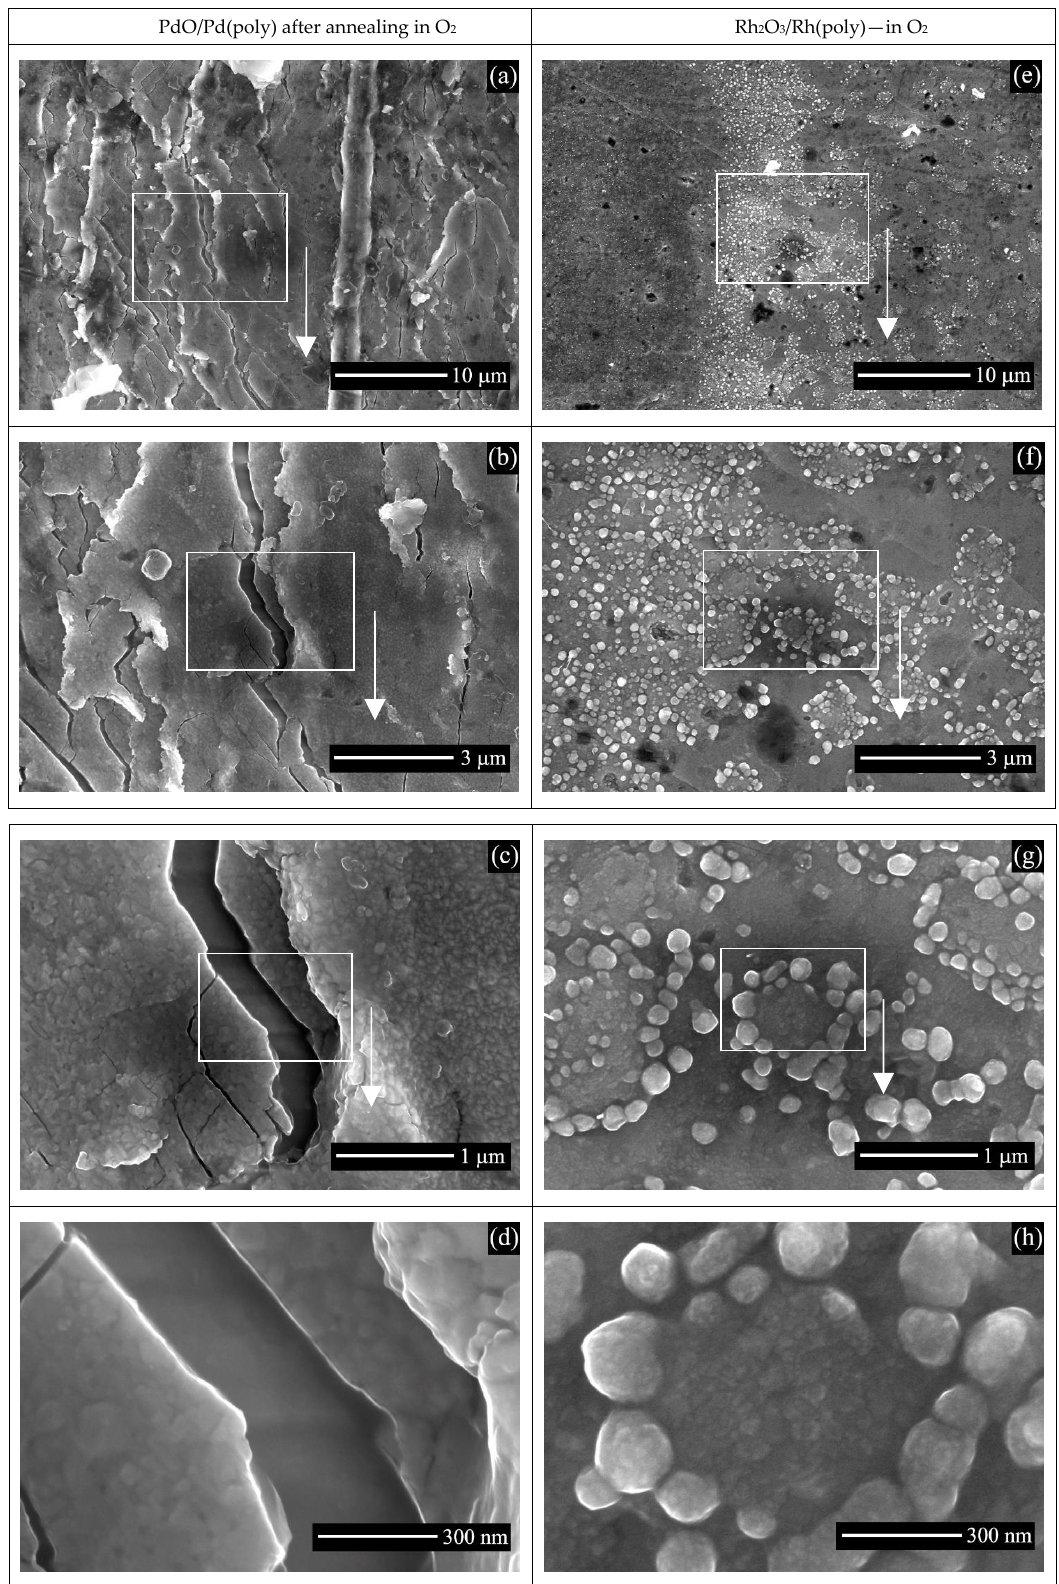
Figure 3. SEM image of the surface of samples Pd(poly) ( a – d ) and Rh(poly) ( e – h ) after annealing in О 2 at Р o 2 = 1 bar and 1100 K for 3 h. Images were obtained in SE mode at E 0 = 20 keV; rectangles indicate the regions represented by images with a higher magnification. For Rh(poly), a continuous dark layer is detected at low magnifications; a vertical strip ca. 10 µm in width consisting of bright particles is seen at the center of this layer (Figure 3e). Images in Figure 3f,g show spherical particles with a size of 100 – 200 nm. One particles. Taking into account that the oxygen concentration in Rh(poly) after annealing in О 2 at 1100 K is equal to 61.1 at.% (Figure 2а), the surface l ayer in Figure 3e – h can be attributed to Rh 2 O 3 oxide. For Rh, Pt and Pd, the 1100 K value is close to the Tamman temperature ( Т / Т melt ~0.5) for these metals because the Т / Т melt value for them is 0.49, 0.54 and 0.6, thus indicating high mobility of atoms of these metals. As a result, recrystalliza- tion and oxidation processes, forming the oxide particles and crystal facets on the grain surface, proceed very intensely. According to Figure 2а, at 1100 K in the О 2 atmosphere, the oxygen concentration on Pt(poly) is ca. 10.0 at.%, on Pd(poly) — 48.6 at.%, and on Rh(poly) — 61.1 at.%. On Pt(poly), O atoms are accumulated on such defects as grain boundaries and dislocations; the dissolution of oxygen in the metal lattice is not observed [21]. On Pd(poly) and Rh(poly), О atoms both penetrate the defects and intercalate in the lattice of metals. These processes lead to the formation of particles and/or crystals of PdO and Rh 2 O 3 oxides on the Pd and Rh surfaces. This is demonstrated by SEM images of the surface of samples after annealing in О 2 at 1100 K. For Pt(poly), the observed surface is typical of the recrystallized polycrystalline metallic sample (Figure S1). For Pd(poly), one can see a cracked and partially decomposed 100 – 200 nm thick oxide layer of PdO particles and/or crystals with a size of 50 – 200 nm (Figure 3a – d). For Rh(poly), a continuous oxide layer of Rh 2 O 3 oxide particles with the size of 25 – 50 nm is observed, which contains large